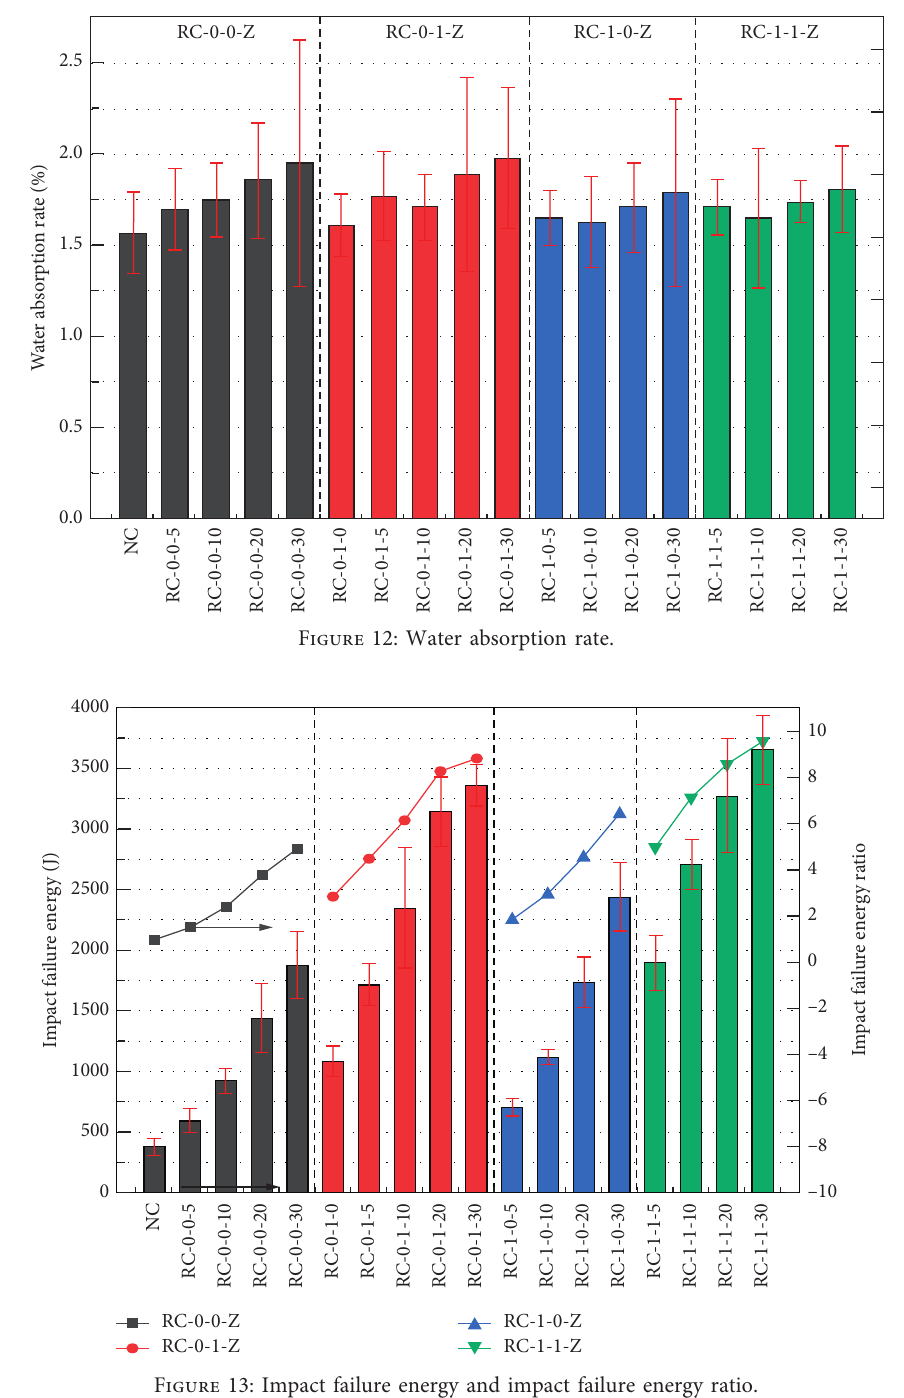
Figure 13: Impact failure energy and impact failure energy